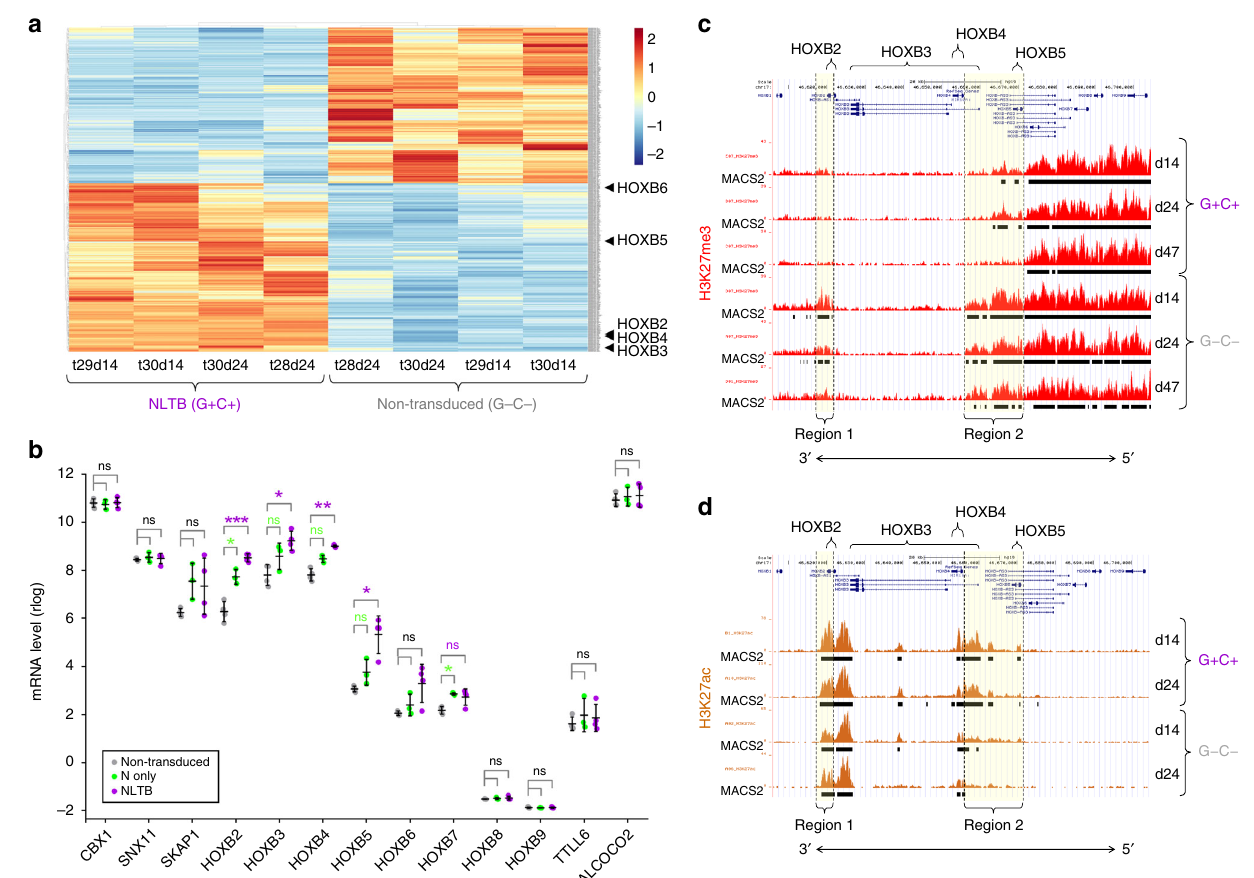
Fig. 5 NLTB induces anterior HOXB gene expression with altered epigenetic patterning. a , b RNA-seq analysis of nascently transduced CB cells. CB cells were transduced with N-GFP and LTB-Cherry lentiviruses, then cultured on OP9-DL1 feeders for 14 – 24 days. RNA was prepared from FACS-sorted doubly (G + C + ), singly (G + C − ), and nontransduced (G − C − ) subsets. Sorted G − C + cells did not pass QC and are not shown. Samples were collected from three different experimental trials (t28 − t30). a mRNA expression heatmap. Differentially expressed genes (G + C + vs. G − C − ; log2FC> 1, p -adj < 0.1) are depicted (468 total, 243 up/225 down). Heatmap is scaled by gene ( = row) with mean = 0 and SD = 1. b mRNA expression level of HOXB and fl anking genes. Rlog values from DESeq2 are plotted. Each datapoint represents an individual sample. Bars indicate mean ± SD for each set of colored dots. Statistical comparisons are for doubly vs. nontransduced cells. * p < 0.05; ** p < 0.01; *** p < 0.001; ns not signi fi cant (two-tailed t test with Holm − Sidak correction for multiple comparisons). c , d Histone ChIP-seq tracks for c H3K27me3 and d H3K27ac over the HOXB locus in NLTB (G + C + ) and nontransduced (G − C − ) CB cells cultured for 14, 24, or 47 days on OP9-DL1 feeders. Subsets were FACS sorted prior to fi xation for ChIP. Corresponding MACS2 peak calls are shown below each